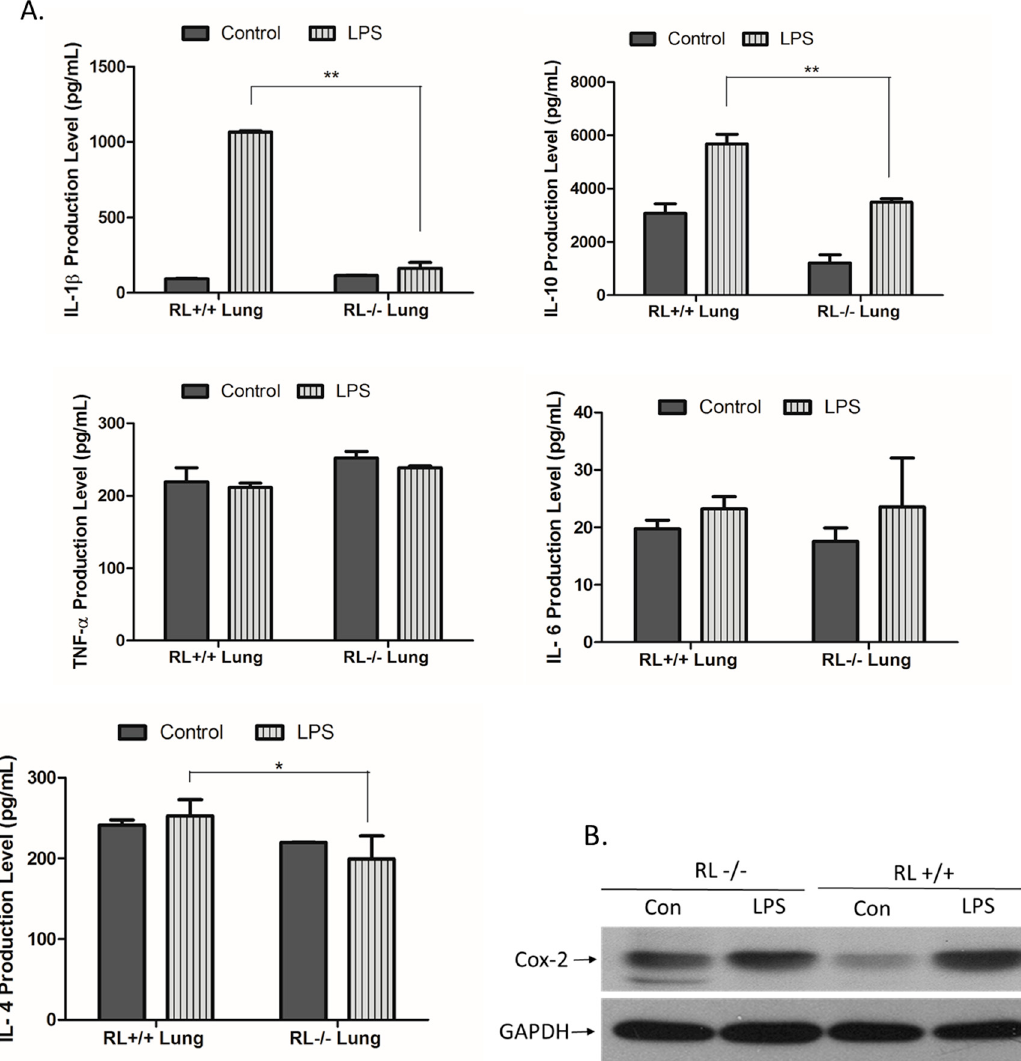
Figure 2. Expression of pro- and anti-inflammatory genes in the lung tissues. ( A ) Lung tissue extracts obtained from RNase L wild type and deficient mice received intranasal instillation of LPS for 24 h. The level of certain cytokines and chemokines in the lung tissue extracts was measured with an ELISA kit for each of the markers. Experiments were performed twice in triplicates. Data are presented as mean ± SD. * p < 0.045, ** p < 0.004. ( B ) The level of Cox-2 in the lung extracts was determined by Western blot with an antibody against mouse Cox-2 (Cayman, MI, USA).